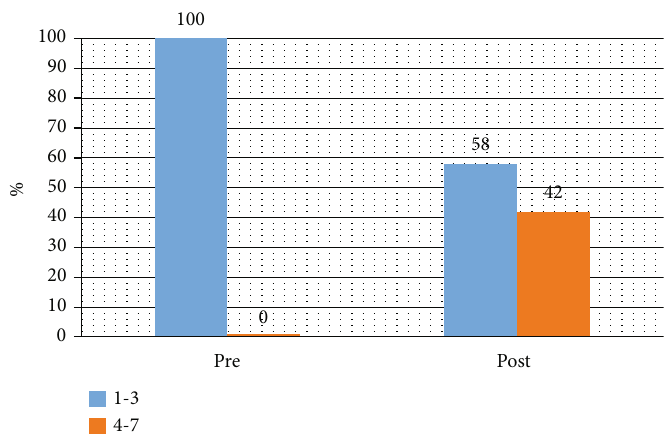
Figure 1: Functional Oral Intake Score (1 – 3: tube dependent, 4 – 7: total oral